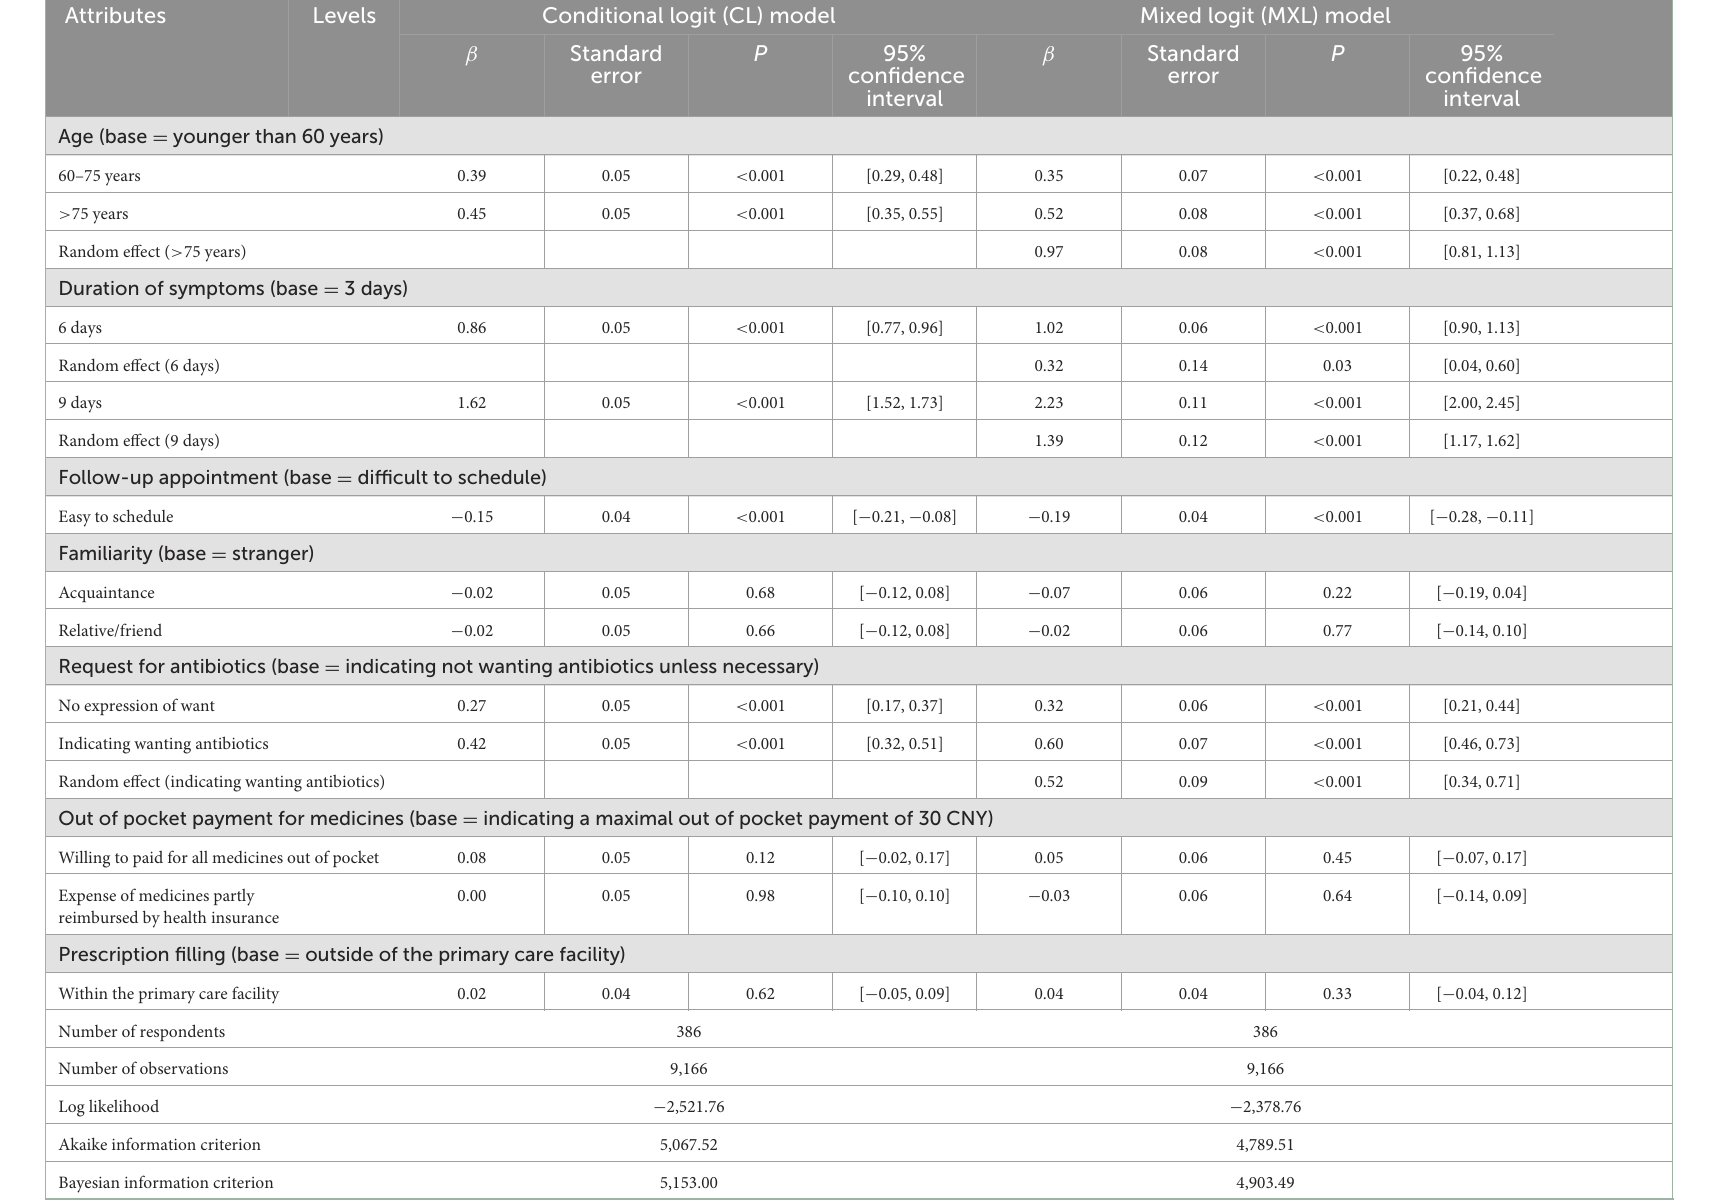
TABLE 4 Results of conditional logit model and mixed logit model against the data set of the discrete choice experiment. Attributes Levels Conditional logit (CL) model Mixed logit (MXL) model β Standard 95% error confidence